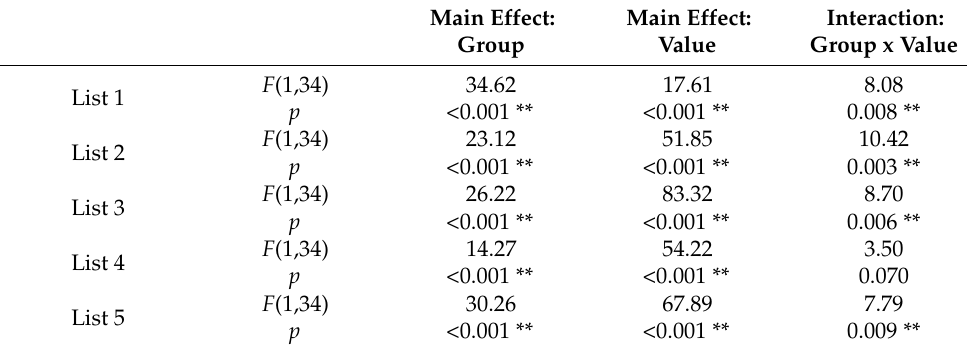
Table 2. Statistical Results for Task-Related Behavioral Data.